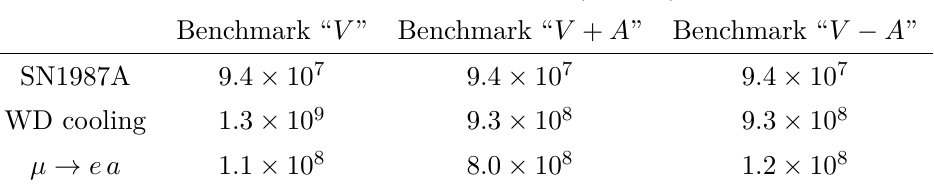
Table 3 . Bounds on the axion decay constant f a (in GeV) for the three bechmarks of the LFV axion model choosing β = 1 , cf. eqs.